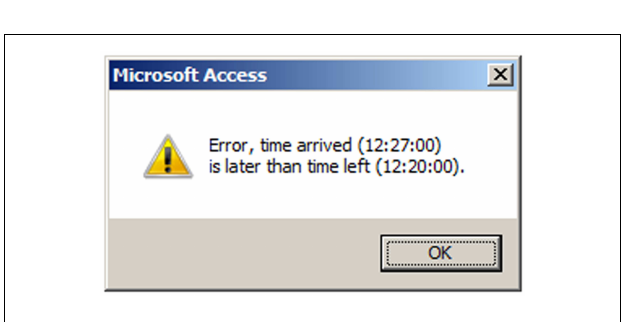
FIGURE 4 | System generated warning for illogical timestamps